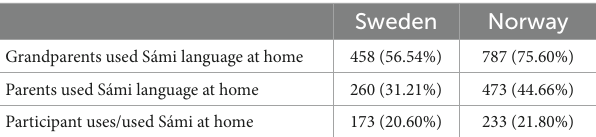
TABLE 4 Use of the Sámi language at home, ethnic Sámi participants (Stage I,